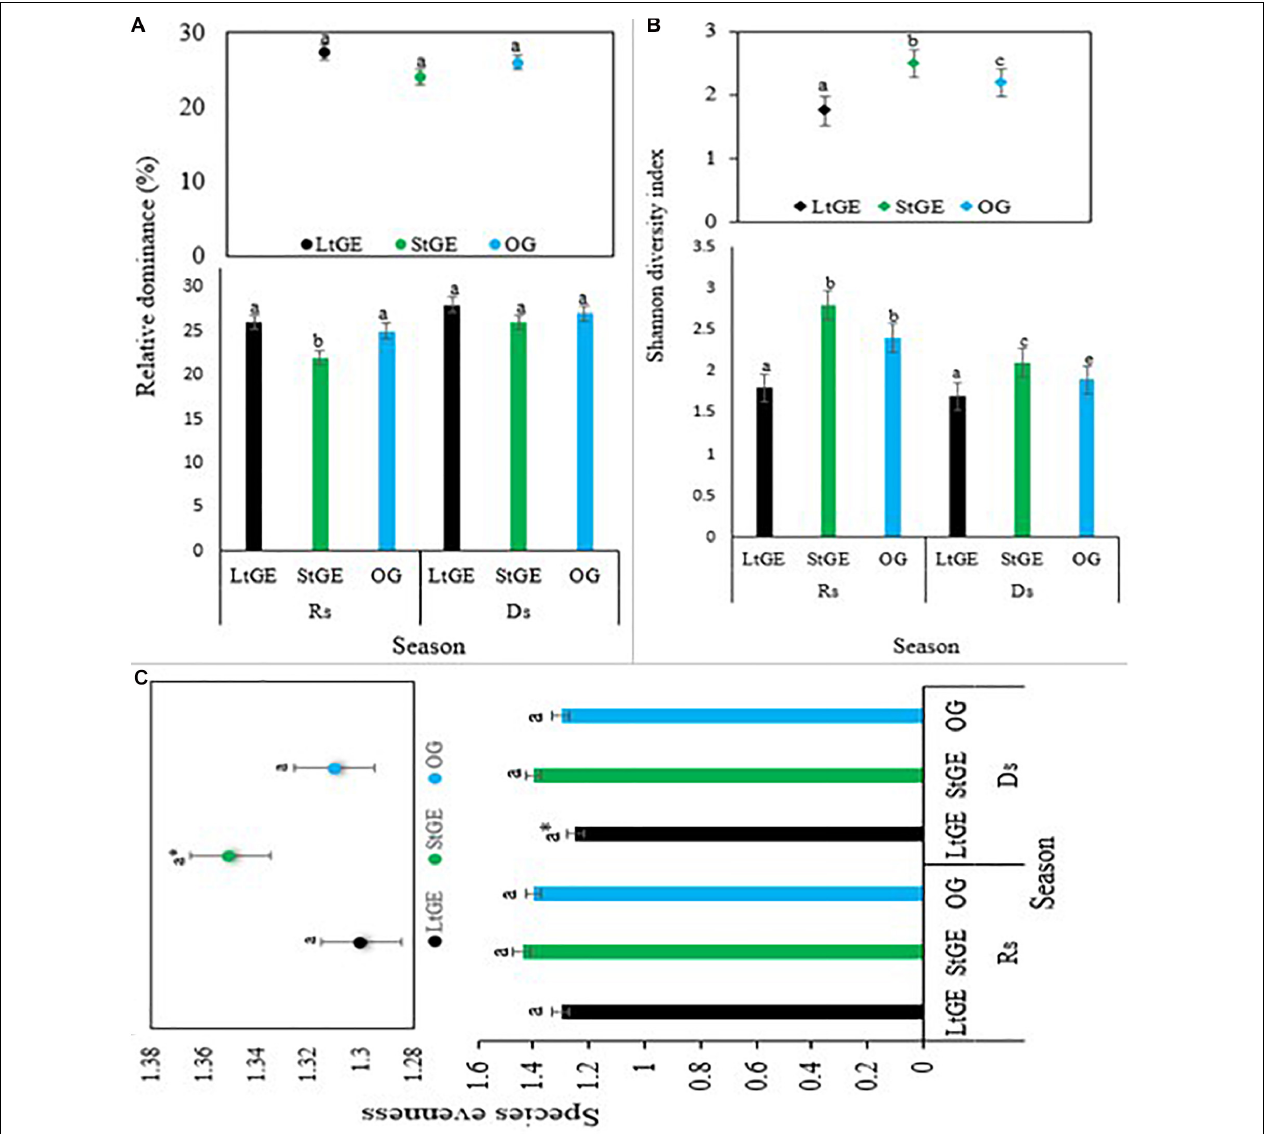
FIGURE 3 | Species relative dominance (A) , Shannon diversity (B) , and species evenness (C) under treatments of grazing enclosure and open-grazing in relation with seasonal variation. Note. LtGE, long-term grazing enclosure; StGE, short-term grazing enclosure; OG, open-grazing; Rs, rainy season; Ds, dry season. a* indicates differences but not significant. Bar plots show seasonal variations and scatter plots attached show the yearly average value. Error bars are shown by standard error. Different lowercase letters within bar plots indicate differences with a significant level ( P < 0.05) between the